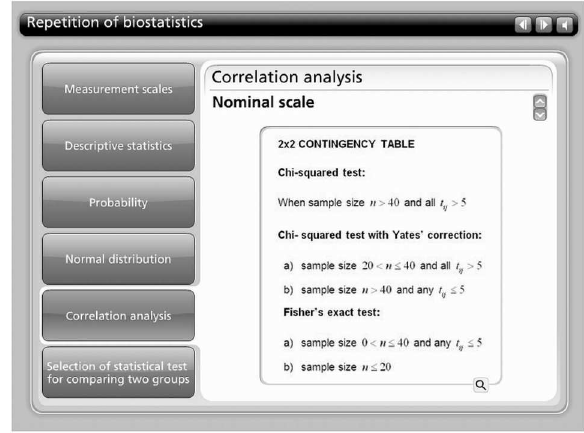
Figure 5. Repetition of biostatistics material using the Tabs interaction